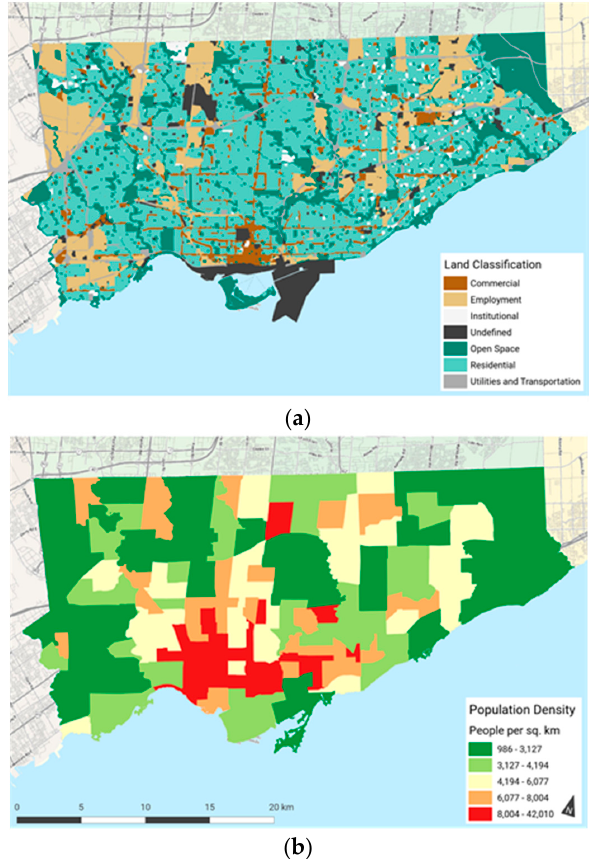
Figure 2. City of Toronto: ( a ) Land use classification; and ( b ) Population density by neighborhood, people per square kilometer.